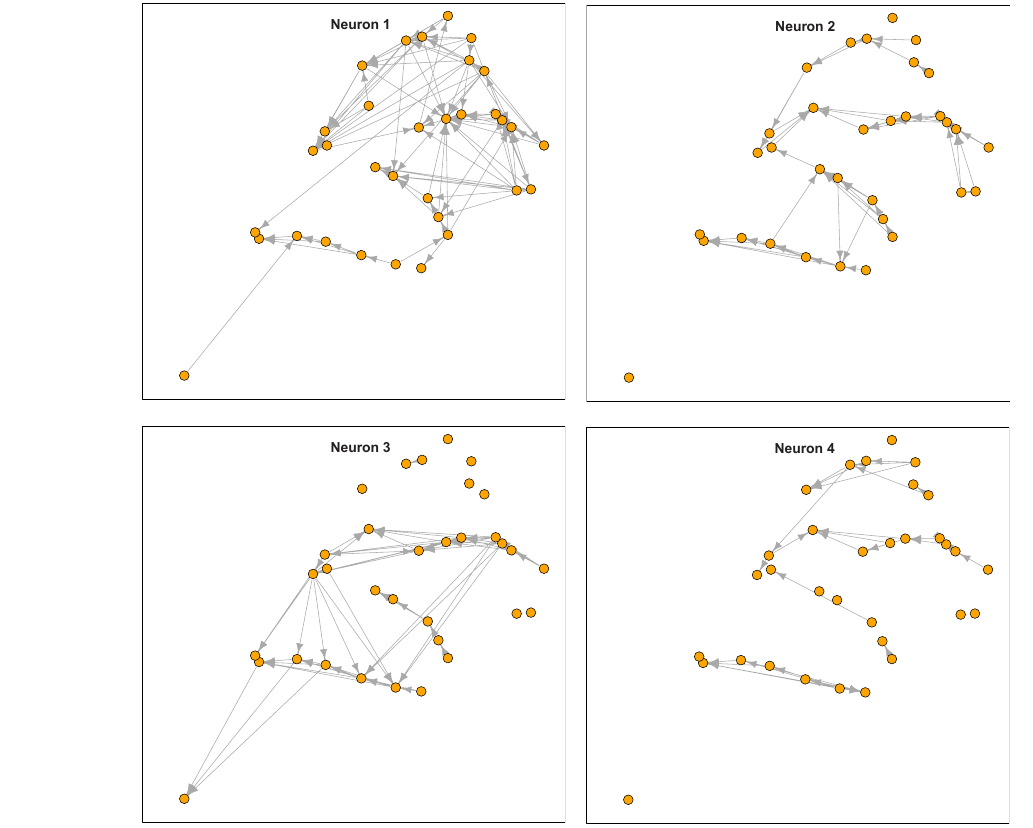
Figure 14. A directed network for the flood events showing synchronization and flow direction (arrows) as a function of neuron class. The dots show the streamflow gauges in their geographical location (see Fig.